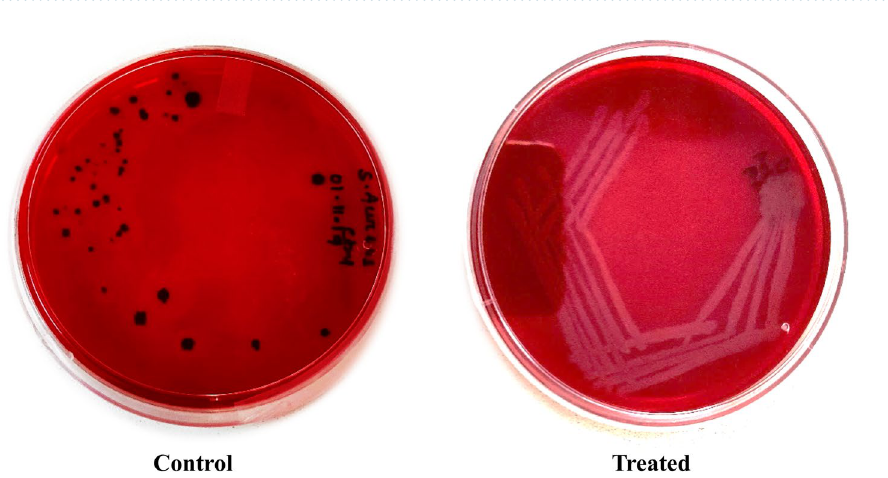
Figure 6. Effect of AgNPs on biofilm production by S. aureus on Congo Red Agar plates. *Control = without AgNPs, Treated = With